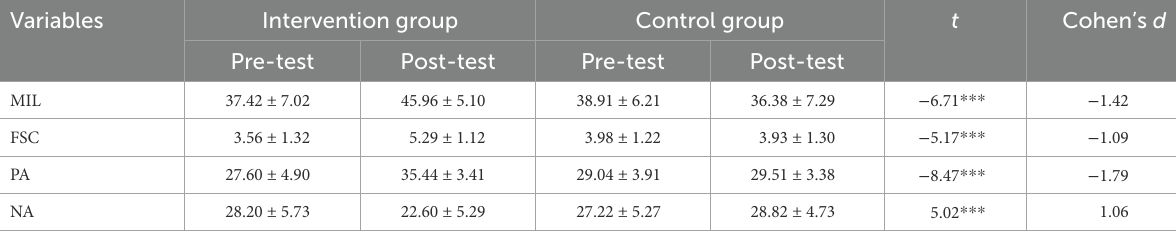
TABLE 2 Pre-test and post-test scores between intervention and control groups ( M ± SD). Variables